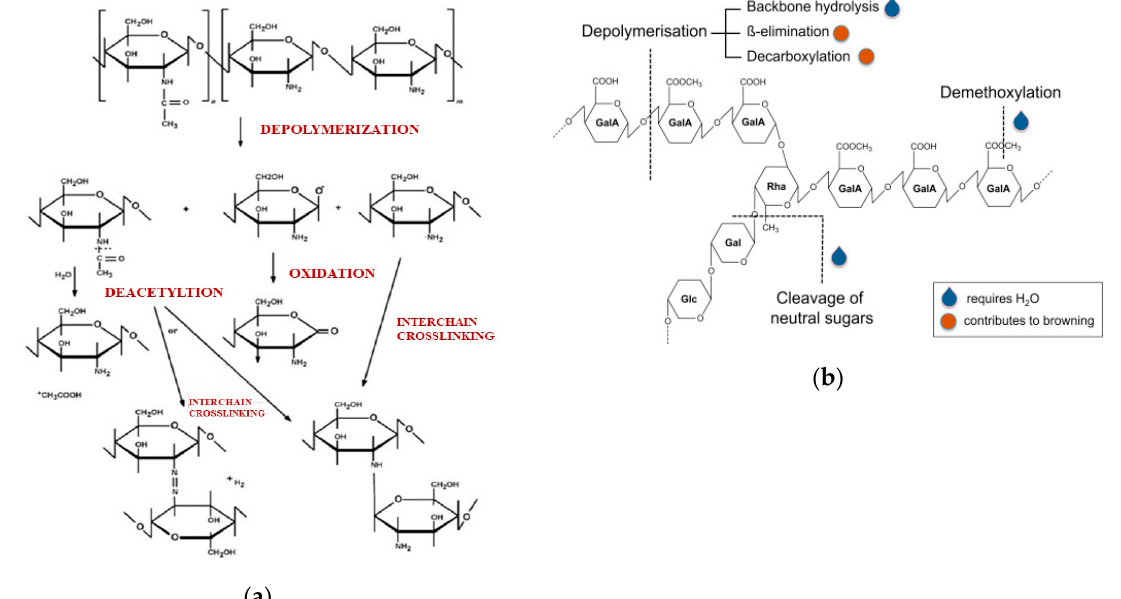
Figure 5. Depolymerization mechanisms of ( a ) chitosan [67] and ( b ) pectin [68].